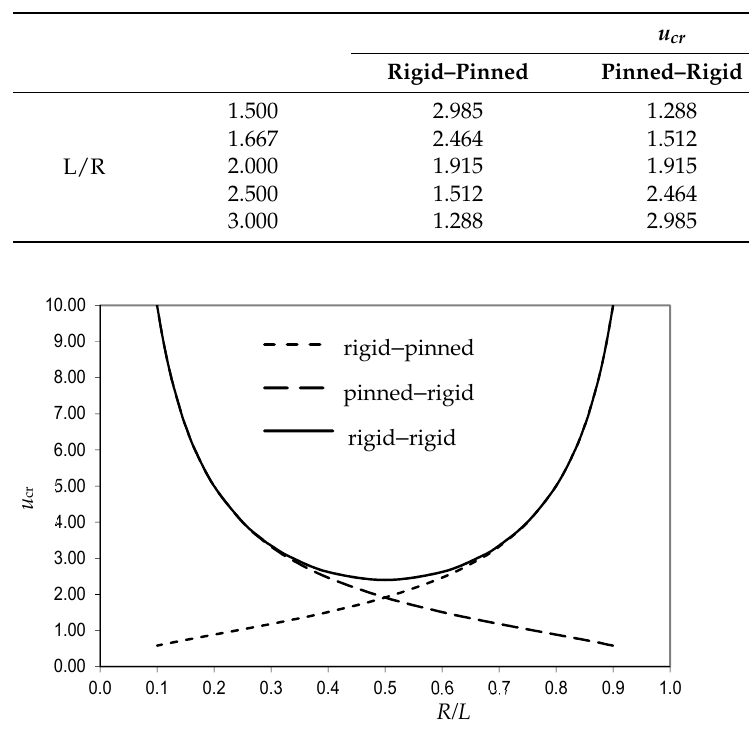
Figure 4. Dependence of roots u cr on the R / L ratio.